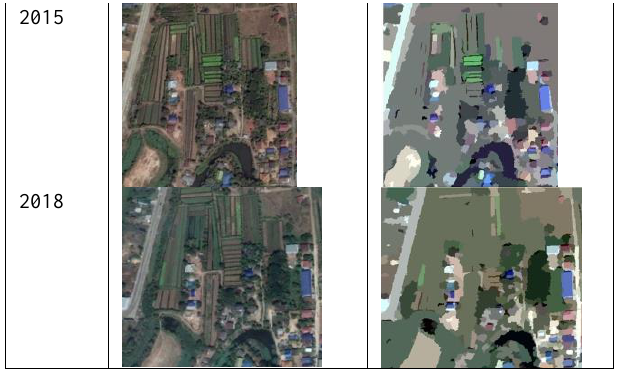
Table 2. Screenshots example of TCs for spatiotemporal